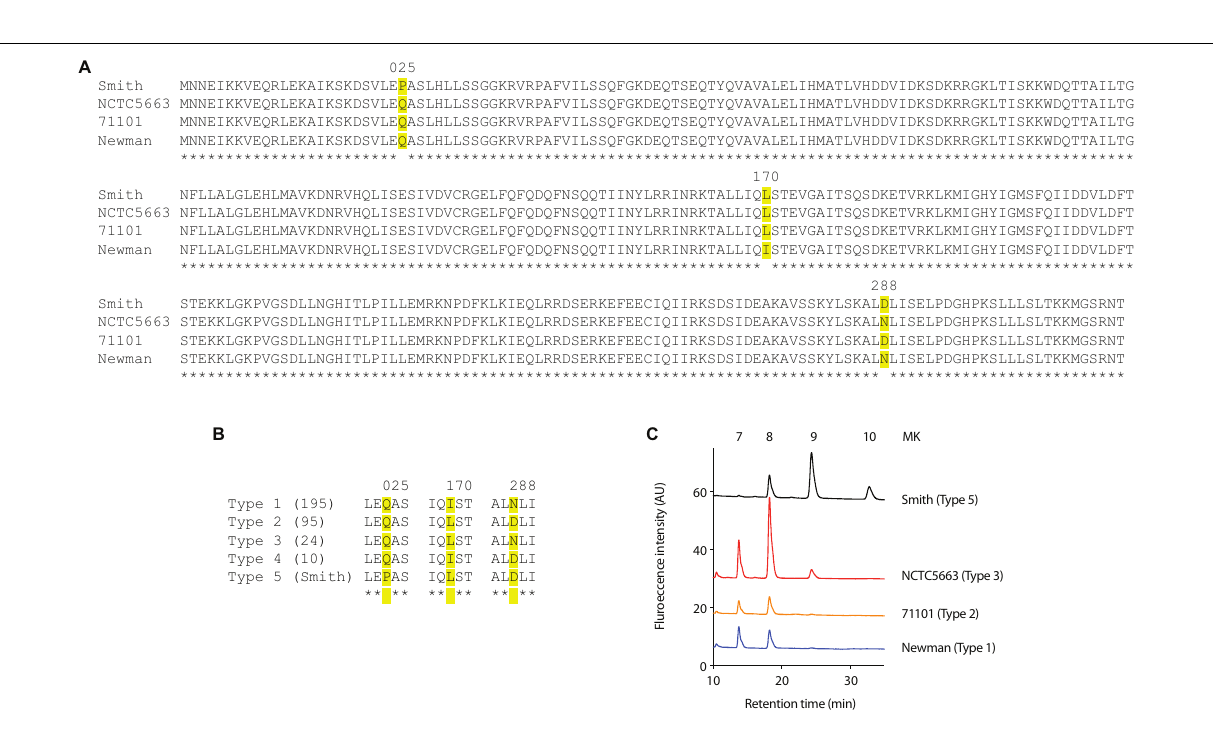
FIGURE 4 | Analysis of Staphylococcal HepTs (A) Alignment of HepT from strains Smith, NCTC5663, 71101, and Newman. (B) Five types of S. aureus based on the position of amino acids at 25, 170, and 288 in the HepT sequence. Numbers in parenthesis indicate the number of strains in each type. Type 5 only contained Smith strain. (C) MK content of representative S. aureus strains to harbor four HepT